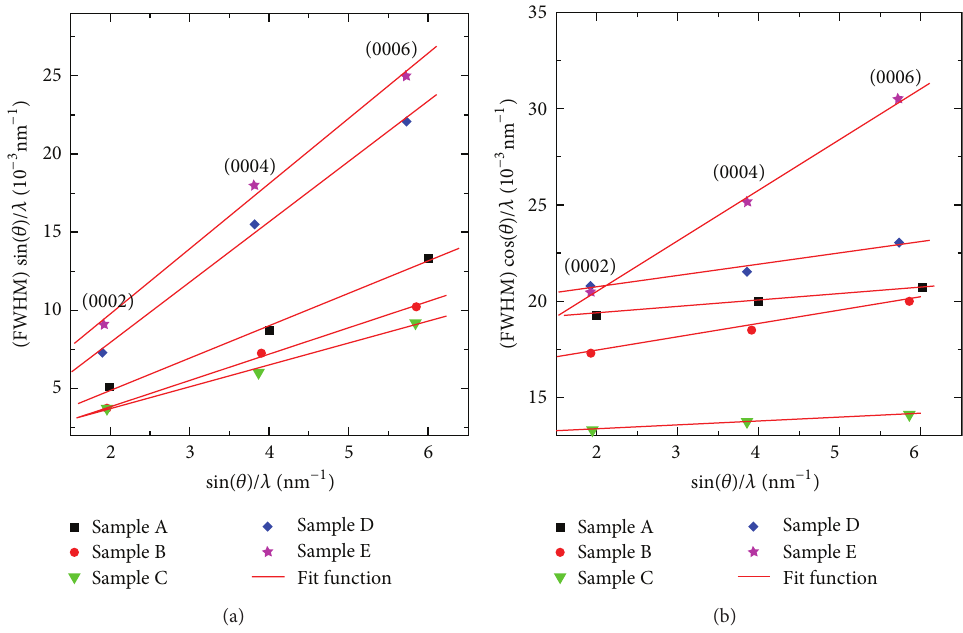
Figure 7: W-H plot for AlInN layers. (a) Triple-axis- 𝜔 -scan and (b) triple-axis 2 𝜃 - 𝜔 -scan were measured for the symmetric ( 000𝑙 ) (𝑙 = 2, 4,6) reflections indicated in the figure. The lines result from a linear fit of the